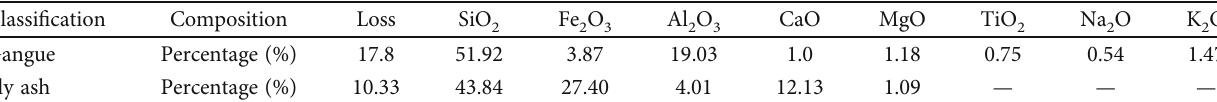
Table 1: Chemical composition of coal gangue and fl y ash.